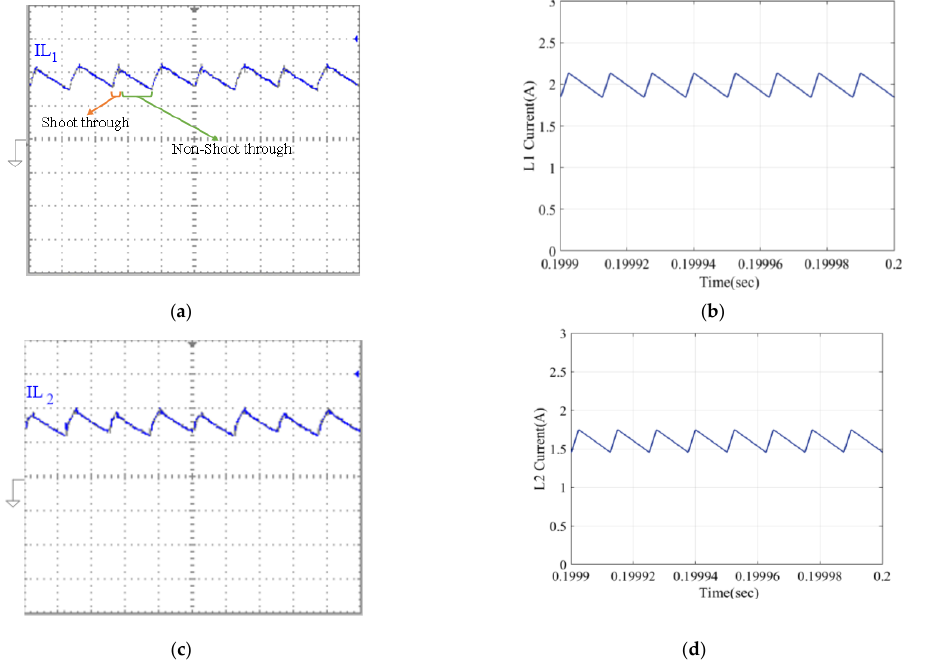
Figure 15. Simulation and experimental results for inductor currents: ( a ) experimental results for I L (Amp / div = 1 A, Time / div = 10 µ s), ( b ) simulation results for I L 1 (Amp / div = 1 A, Time / div = 10 µ s) and ( d ) simulation results for I L